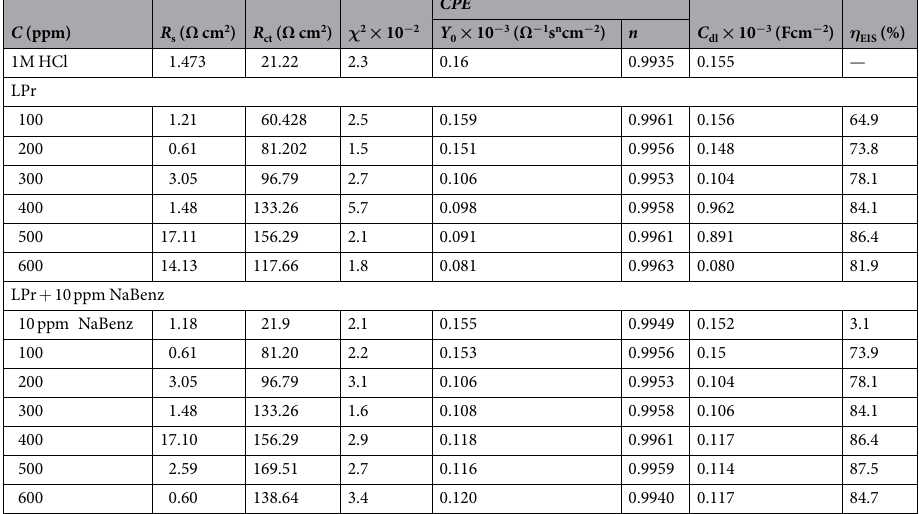
Table 2. EIS parameters of MS in 1M HCl in absence and presence of varying concentrations of LPr and LPr + 10 ppm NaBenz inhibitors at 30 °C.